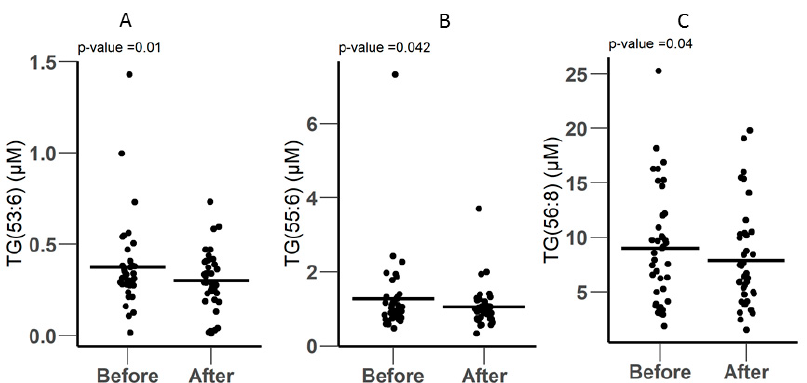
Figure 3. ( A – C ) Differentially expressed TGs before and after surgery, as measured by LC-MS using the biocrates P400 kit.